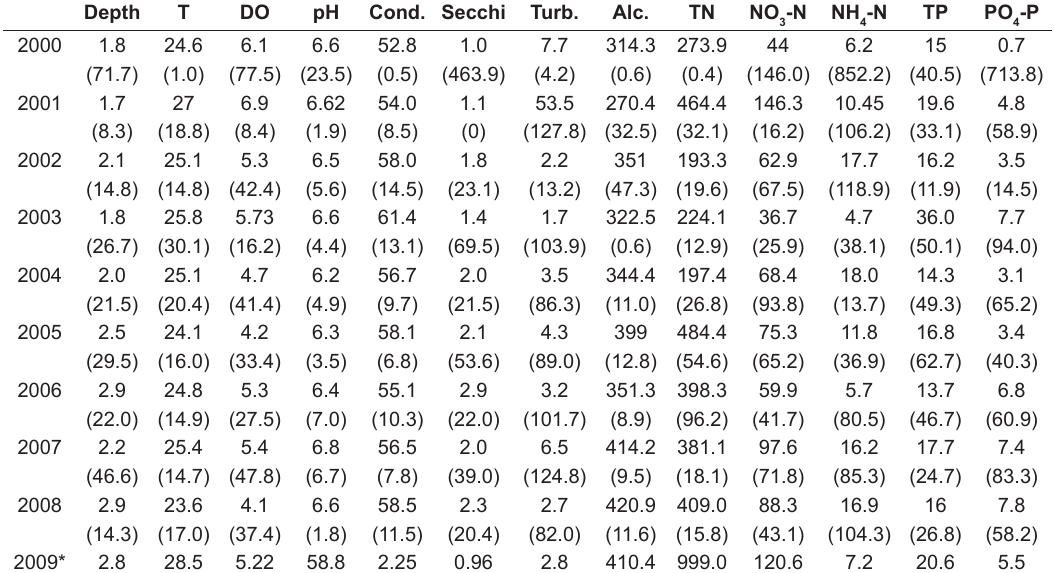
Figure 2. Hydrometric levels of the Paraná River (lines) and Zmax of the floodplain lake (points) from February 2000 to March 2009. Points also indicate the sampling days. Table 1. Mean values and coefficient of variation (% in parentheses) of the abiotic variables sampled in the Pau Véio lake between March 2000 and March